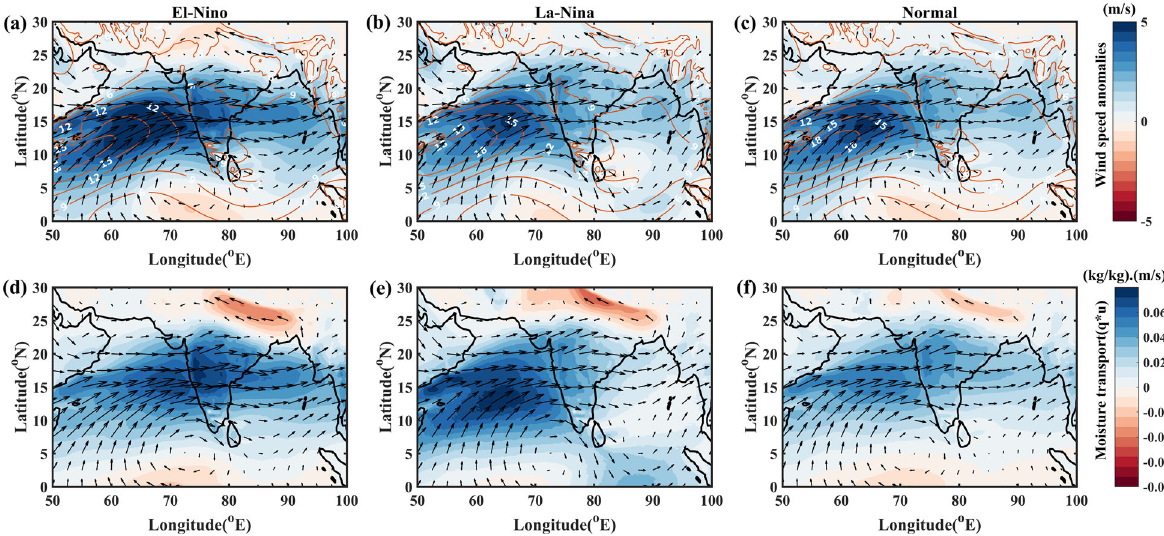
Fig. 5 Changes in wind pattern and moisture transport over the AS. a – c The contour shows the climatological wind speed, the colour bar shows the wind speed anomalies during high AOD over the AS w.r.to climatology, the vector shows the anomalies in wind direction. d – f The colour bar indicates moisture transport anomalies at 850 hPa level (q*u), the vector shows wind direction